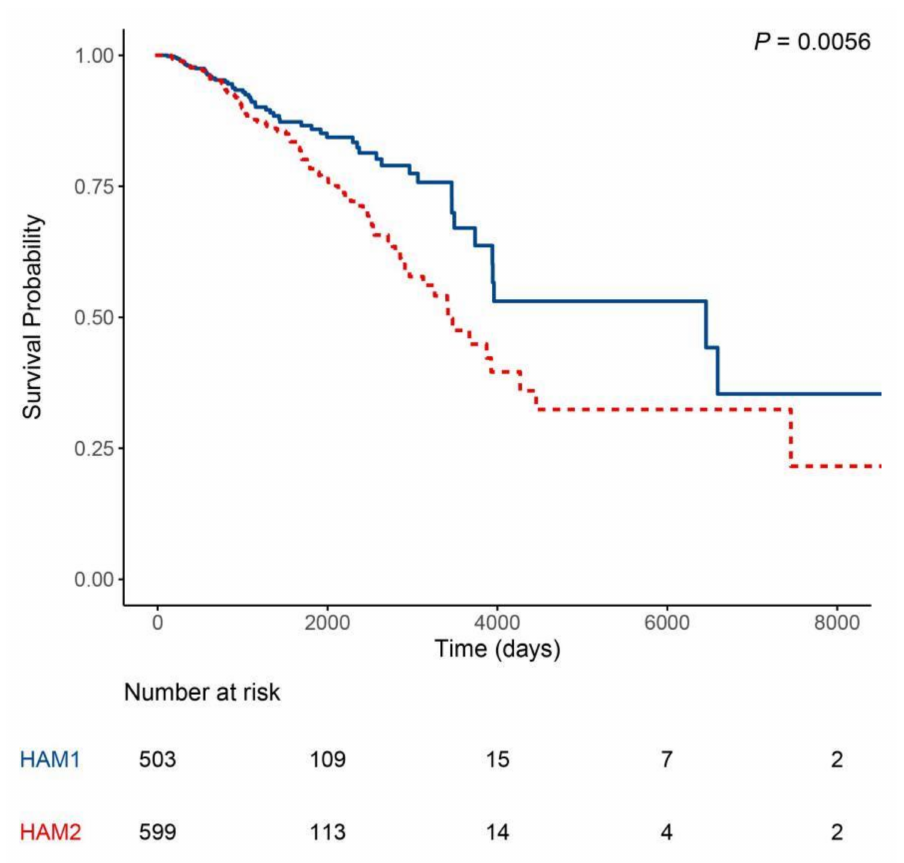
Figure 4. Kaplan–Meier estimate of the overall survival for HAM1 and HAM2 groups of